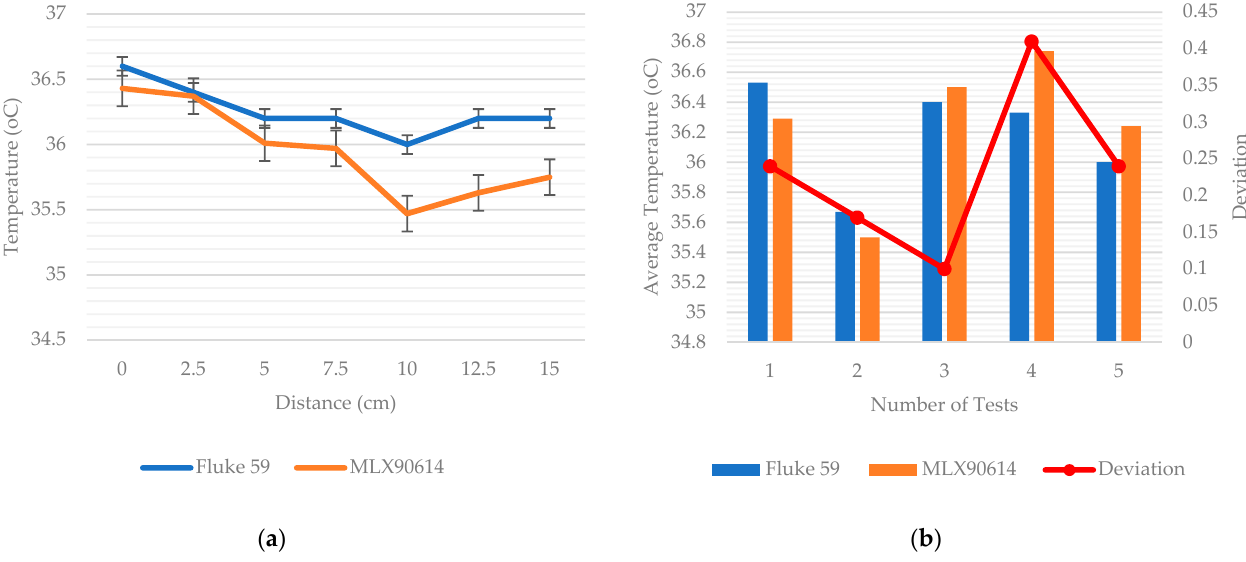
Figure 11. ( a ) The temperature of the forehead from various distances using Fluke 59 and MLX90614; ( b ) average temperature with Fluke 59 and MLX90614 fixed at a distance of 3 cm.